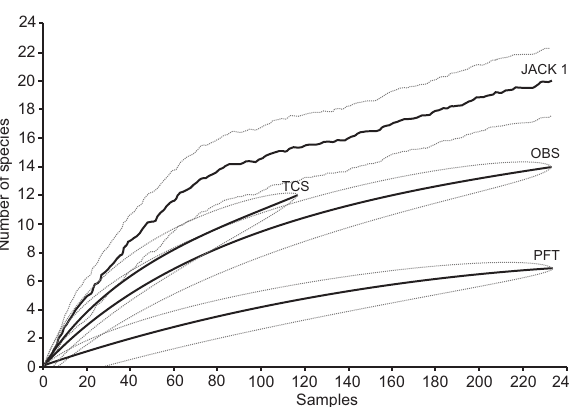
Figure 9. Species accumulation curve, richness estimates and per- formance of two different methods employed to sample snakes at Castelo do Piauí. Samples were generated after 100 random- izations. (TCS) Time constrained search (1 sample = 8 man-hours); (PFT) pitfall traps (1 sample = 28 days/trap). Jack 1 = 1 st order Jackknife richness estimator; OBS = observed richness.